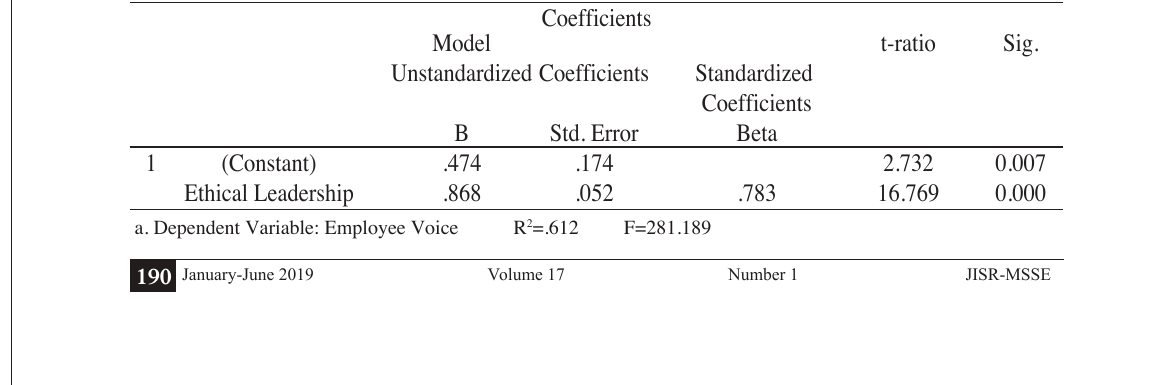
Table 6. Regression Analysis between ethical leadership and Employee